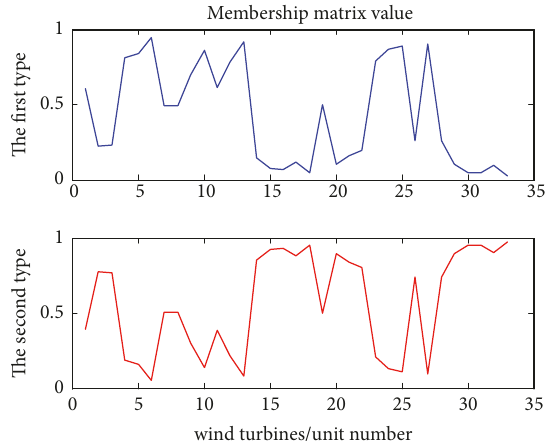
Figure 4: Membership matrix value curves of two types of units.